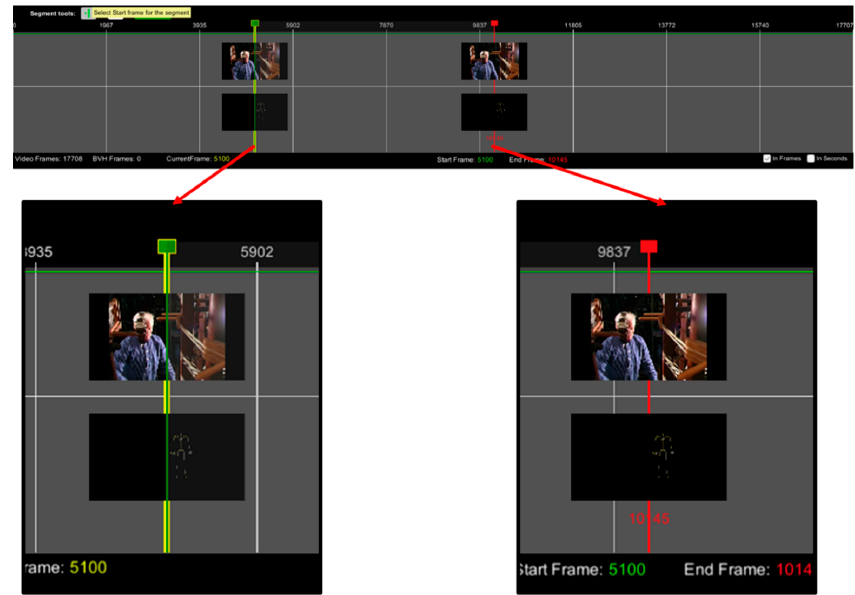
Figure 4. Timeline component (visualisation of start and end video and skeleton frame).